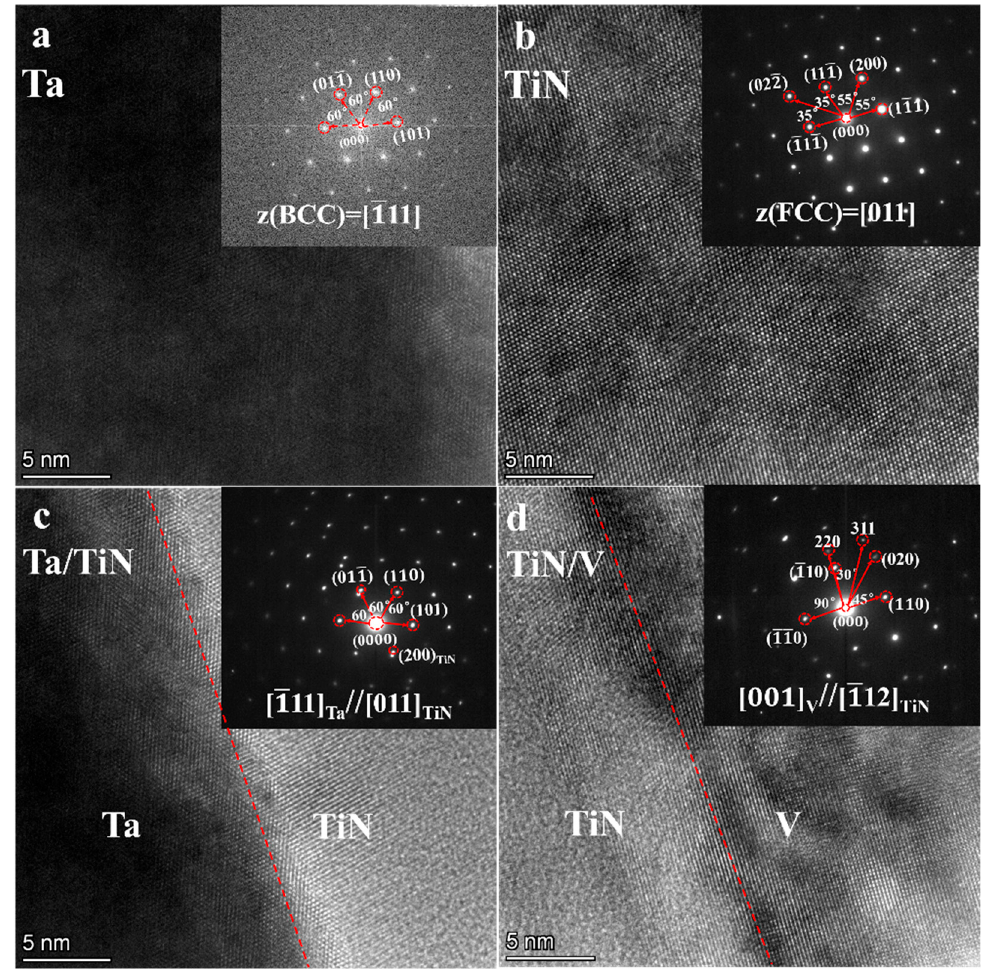
Figure 17. HR-TEM images and the orientation relationships of the interface of W/V/TiN/Ta composites as SPSed at 1200 °C: ( a ) Ta; ( b , d ) TiN; ( c ) Ta–TiN interface; and ( d ) V–TiN interface. Table 8. δ and D values of parallel crystal planes in W/V/TiN/Ta composites. Interplanar Distance/nm Joining Temperature/°C δ /% D/nm